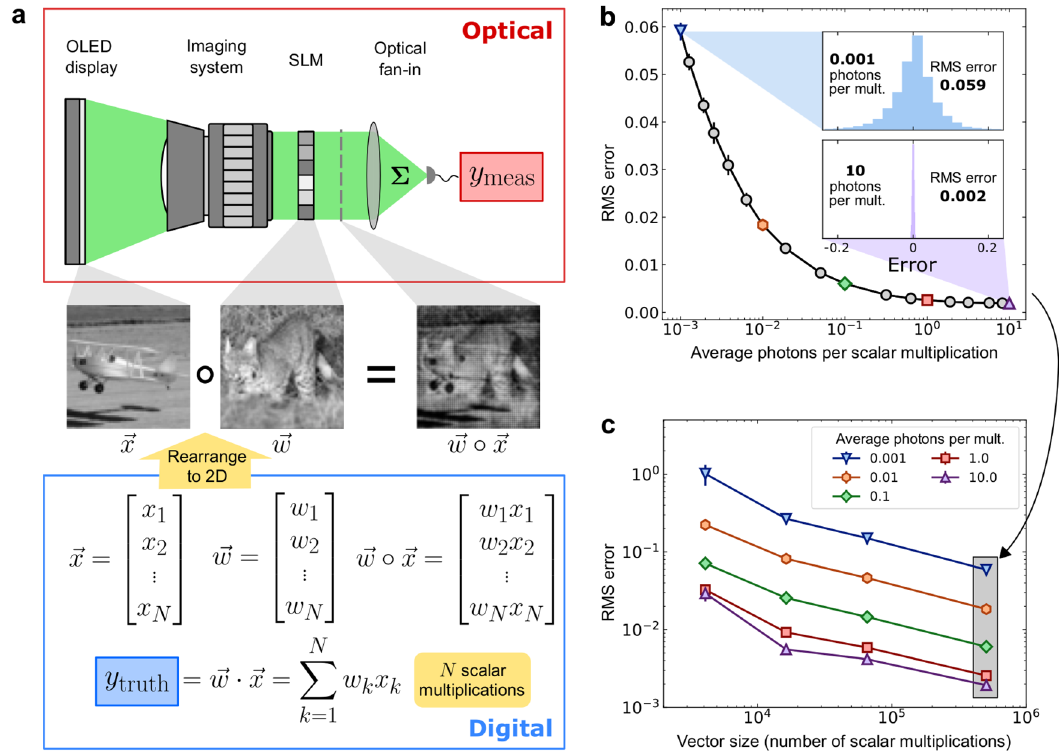
Fig. 2 Vector-vector dot products were computed with high accuracy using as few as 0.001 photons per scalar multiplication. a The procedure for characterizing optical vector-vector dot products. N -pixel images were used as test vectors by interpreting each image as an N -dimensional vector. The setup was used to compute the dot products between many different random pairs of vectors, with each computation producing a result y meas (top and * (cid:1) * center rows; example experimental measurement of element-wise multiplication w was captured with a camera before optical fan-in for illustrative x purposes). The dot-product ground truth y truth was computed on a digital computer (bottom row). The error was calculated as y meas (cid:4) y truth. OLED: organic light-emitting display; SLM: spatial light modulator. b The root-mean-square (RMS) error of the dot product computation as a function of the average number of detected photons per scalar multiplication. The vector length N was ~0.5 million (711 × 711). The error bars show 10× the standard deviation of the RMS error, calculated using repeated measurements. The insets show error histograms (over different vector pairs and repeated measurements) from experiments using 10 and 0.001 photons per multiplication, respectively. c The RMS error as a function of the vector size N . For each vector size, the RMS error was computed using fi ve different photon budgets, ranging from 0.001 to 10 photons per scalar multiplication. The shaded column indicates data points that are also shown in ( b ). The error bars show 3× the standard deviation of the RMS error, calculated using repeated repetition. The simulation curve (Fig. 3b, center panel, dark-blue line) was produced by executing the same trained neural network model completely on a digital computer with simulated shot noise, but without modeling any other physical process in the experimental setup. The only cause for the classi fi cation accuracy of the simulation curve to drop at lower photon budgets is the presence of the simulated photon shot noise. The reasonable agreement between the experimental and the simulation results supports the hypothesis that the classi fi cation accuracy of the experimental ONN was primarily limited by the photon detection shot noise at low photon budgets, and indeed the SNR measured by the detector was close to the shot-noise limit (Supplementary Fig. 10).